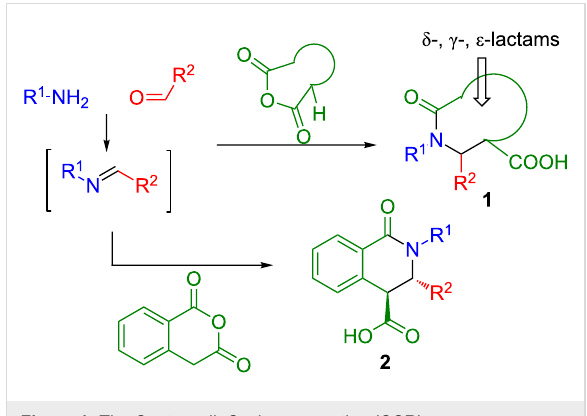
Figure 1: The Castagnoli–Cushman reaction